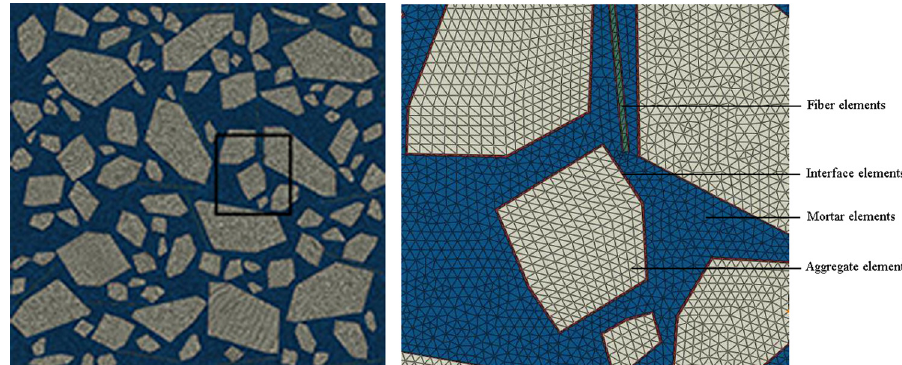
Figure 5: Meshing of the steel – polypropylene HFRC.